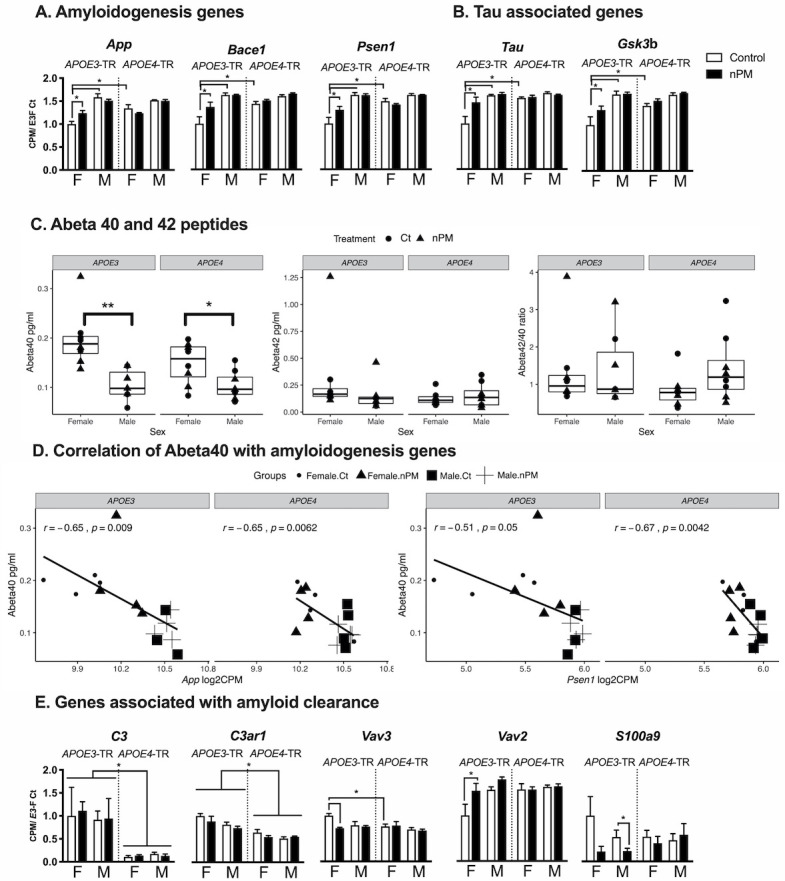
AD-associated gene responses to nPM in cerebral cortex.(A) Amyloidogenic pathway responses. Female APOE3 had largest nPM response. (B) Tau and its kinase, Gsk3b. (C) Levels of Aβ40 and Aβ42 peptides did not respond to nPM. However, females had higher Aβ40 (pg/ml) of both APOE3 and APOE4 mice. **p<0.01, *p<0.05 in t-test. (D) Aβ40 peptide was negatively correlated with amyloidogenesis gene expression including App (r = −0.65), and Psen1 (r = −0.51 to −0.67). The expression was reported as Log2 count per million (cpm). (E) Aβ-amyloid clearance pathway responses to nPM. A small subset (10%, 5/46) of amyloid clearance genes differed by APOE or nPM (genes identified in the IPA database for phagocytosis, proteolysis, degradation, deposition). Only APOE3 responded to nPM. Mean ± SEM. ANOVA; FDR multiple test correction. * Adj. p-value, 0.05. Sample size: 4/genotype/sex/treatment.